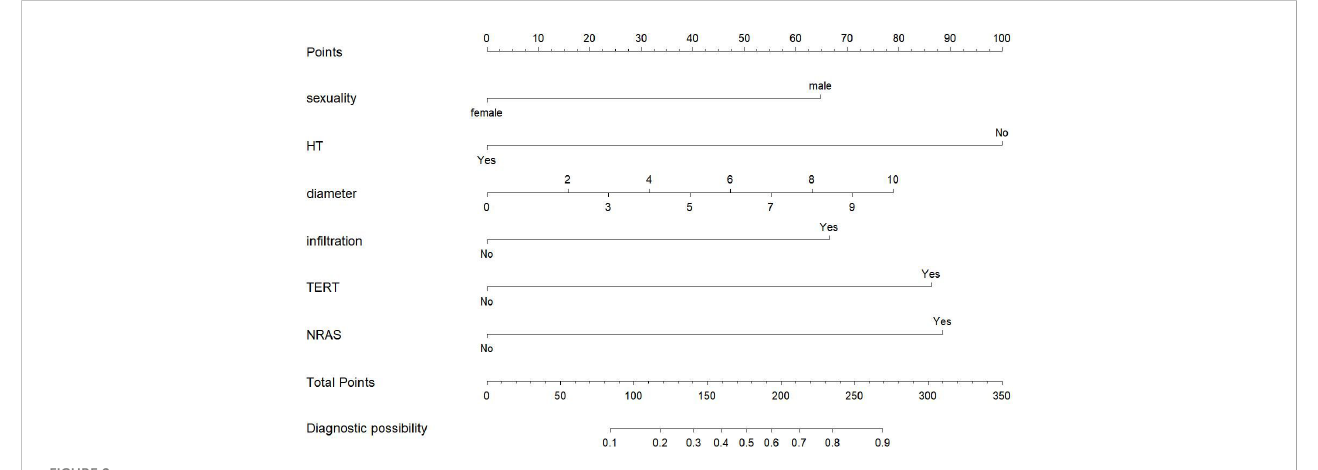
FIGURE 2 Nomogram for prediction